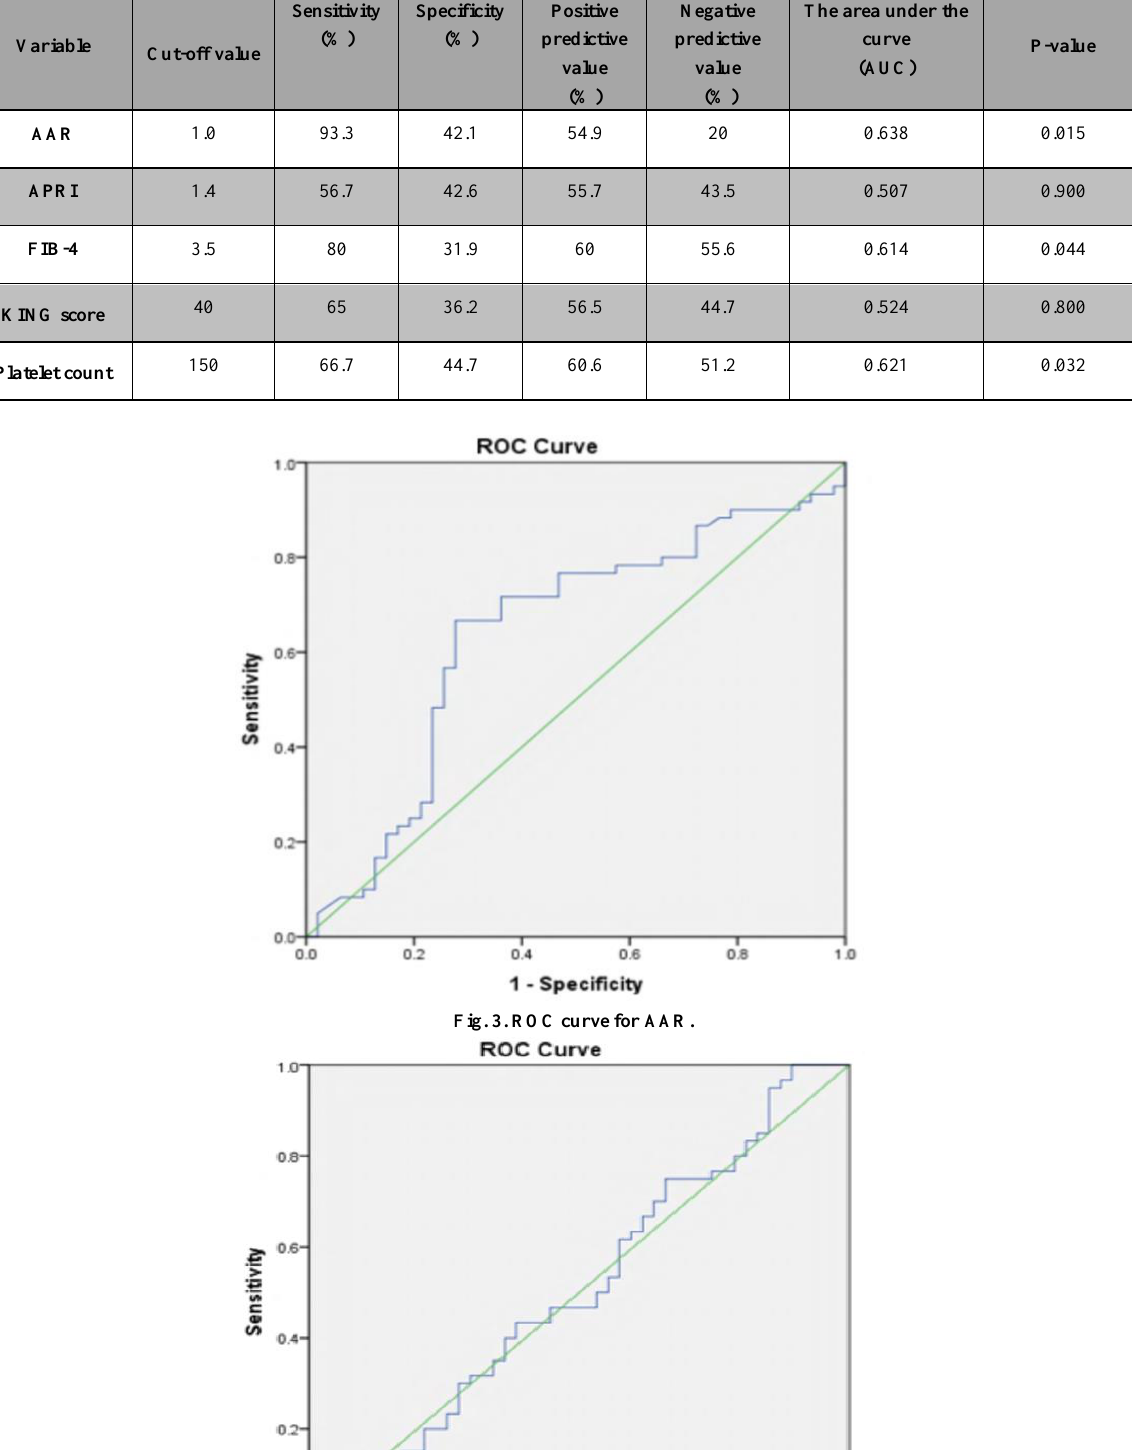
Fig. 3. ROC curve for AAR.